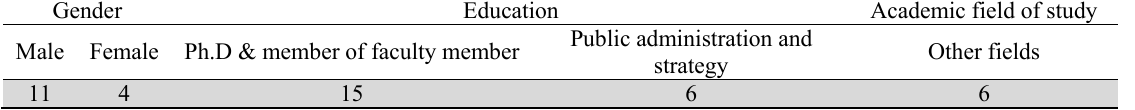
Descriptive statistics of the experts and specialists population Gender Education Academic field of study Male